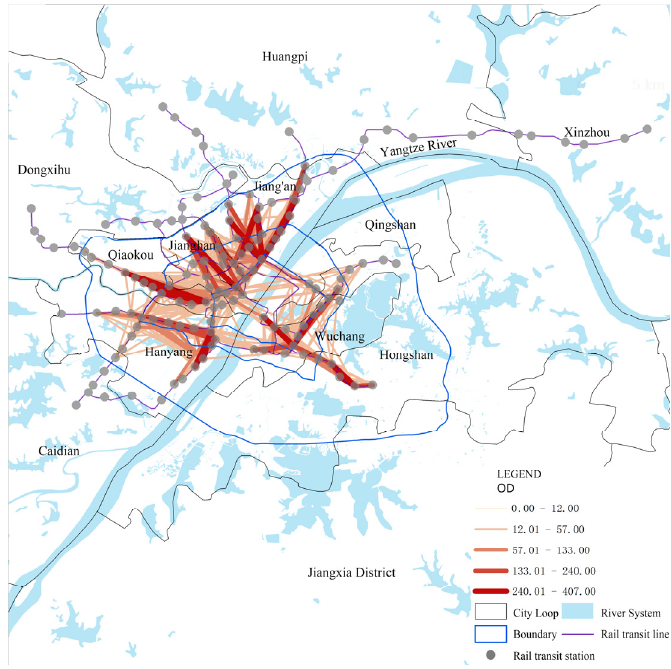
Figure 3. Distribution of metro travel direction for the elderly.